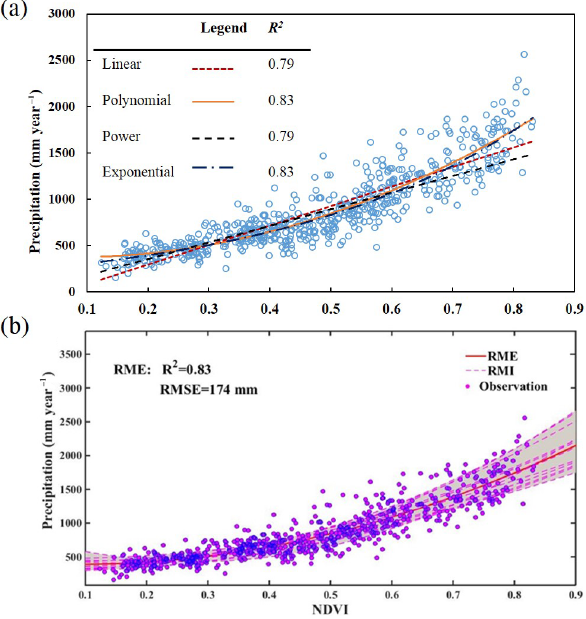
Figure 3. (a) Different regression form between annual precipita- tion and NDVI; (b) the NDVI–precipitation relationships for RME and